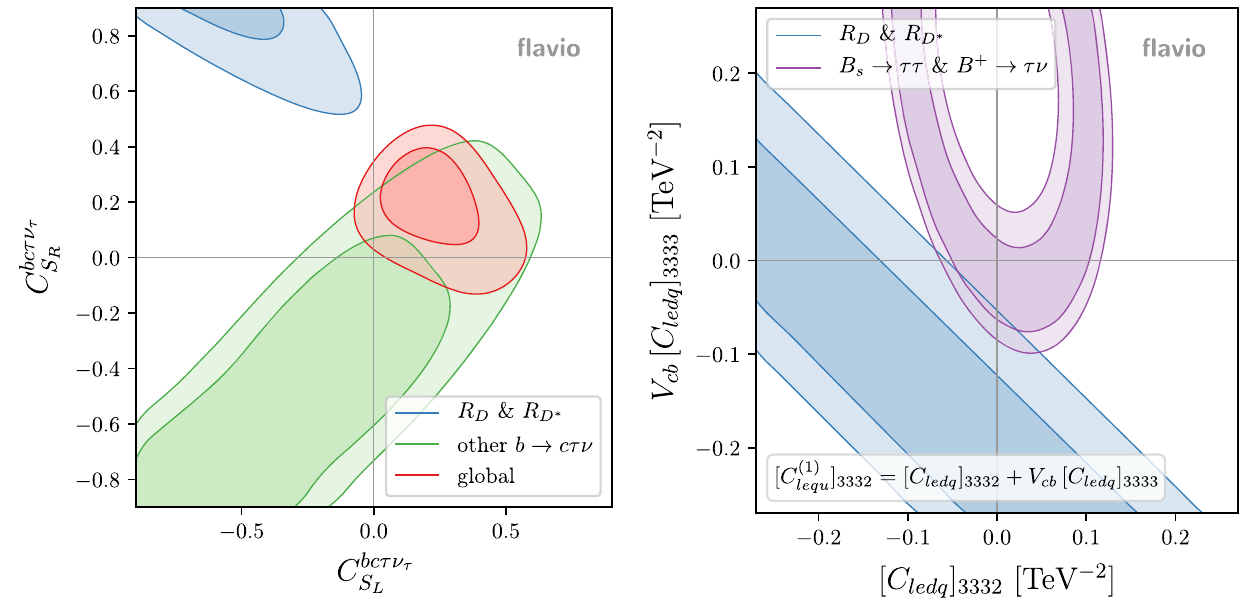
Wilson coefficients matching onto the WET scalar operators for two choices of flavour indices, imposing the relation between coefficients (11) that evades the B c → τν constraint. The purple region is allowed